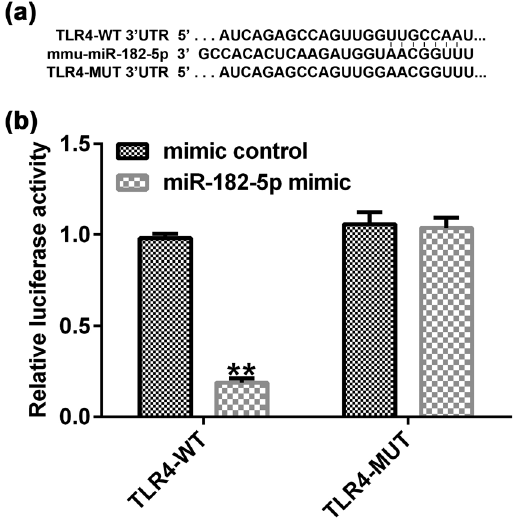
Figure 1: TLR4 is a target gene of miR - 182 - 5p. ( a ) Prediction of miR - 182 - 5p targeting TLR4 by the miRNA target gene database TargetScan. ( b ) The dual luciferase reporter gene assay was used to verify the association between miR - 182 - 5p and TLR4 when 293T cells were transfected with miR - 182 - 5p mimic and wild - type or mutant TLR4 3 ′ - UTR reporter ( n = 3 ) . TLR4, toll - like receptor 4; miRNA,